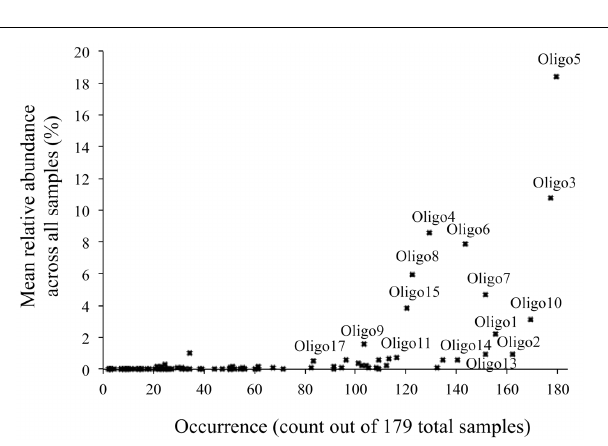
FIGURE 6 | Commonness and abundance plot of all oligotypes that were part of the mixed habitat sample grouping analysis (Table 2). The occurrence (presence/absence) of each of the 99 oligotypes across all 179 samples is plotted along the x-axis while its mean relative abundance across all samples is plotted on the y-axis. Samples that are both common and abundant are found in the top right, while those that are common, but rare are in the bottom right. Both rare and uncommon are found in the bottom left. The top 17 most abundant oligotypes from Table 3 are also labeled.